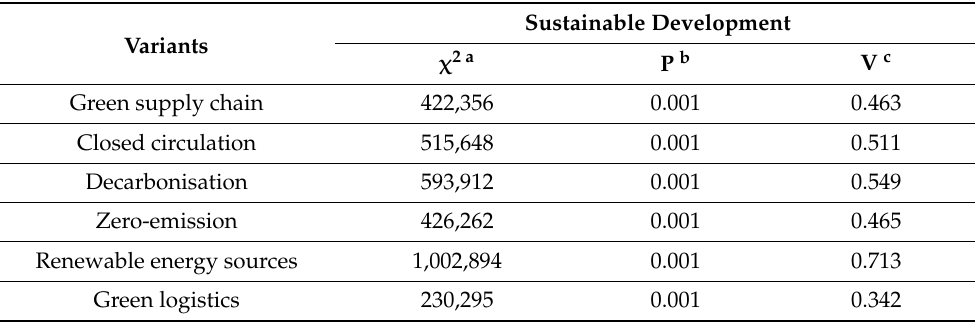
Table 5. Representation of the concept of sustainable development in relation to forms of environ- mental activities as represented by the results of a χ 2 independence test.